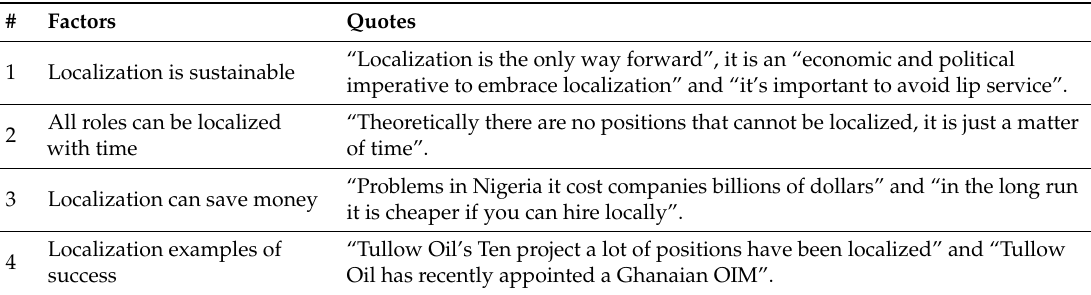
Table 13. ‘Localization of the workforce’